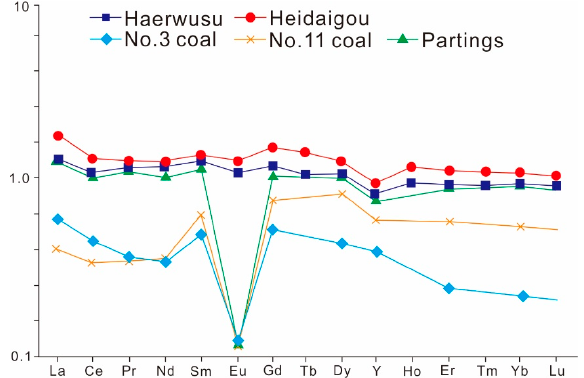
Figure 6. The upper continental crust (UCC)-normalized rare earth elements and yttrium (REY) distribution patterns of the studied samples in comparison to those of Haerwusu [48] and Heidaigou coals [49].